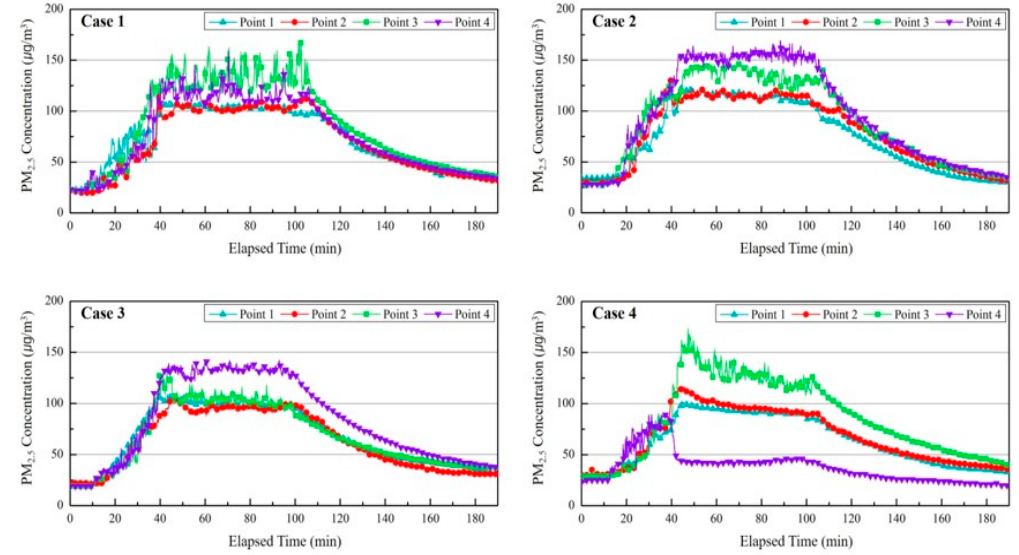
Figure 9. Comparing PM 2.5 concentrations by measurement points ( Case 1–4 ).